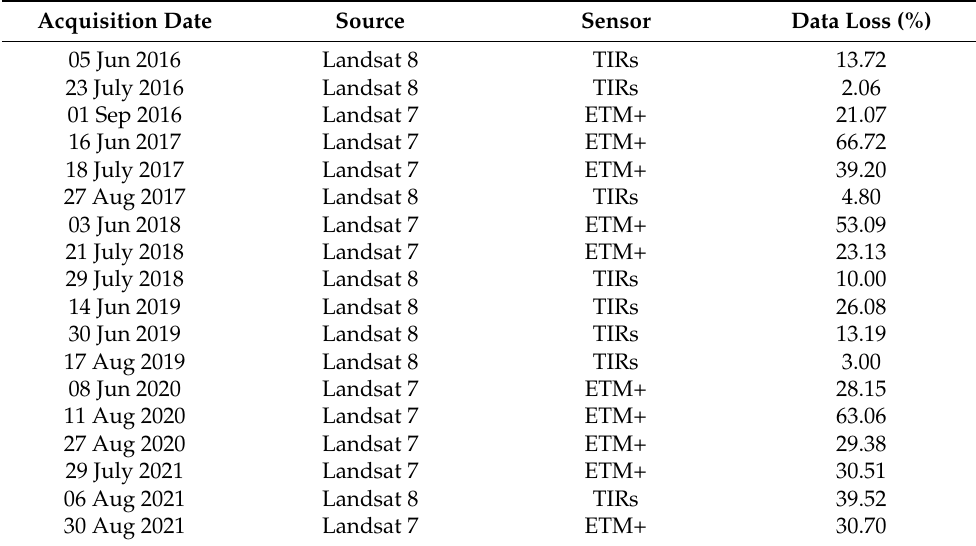
Table 2. Characteristics of LST data remaining to be